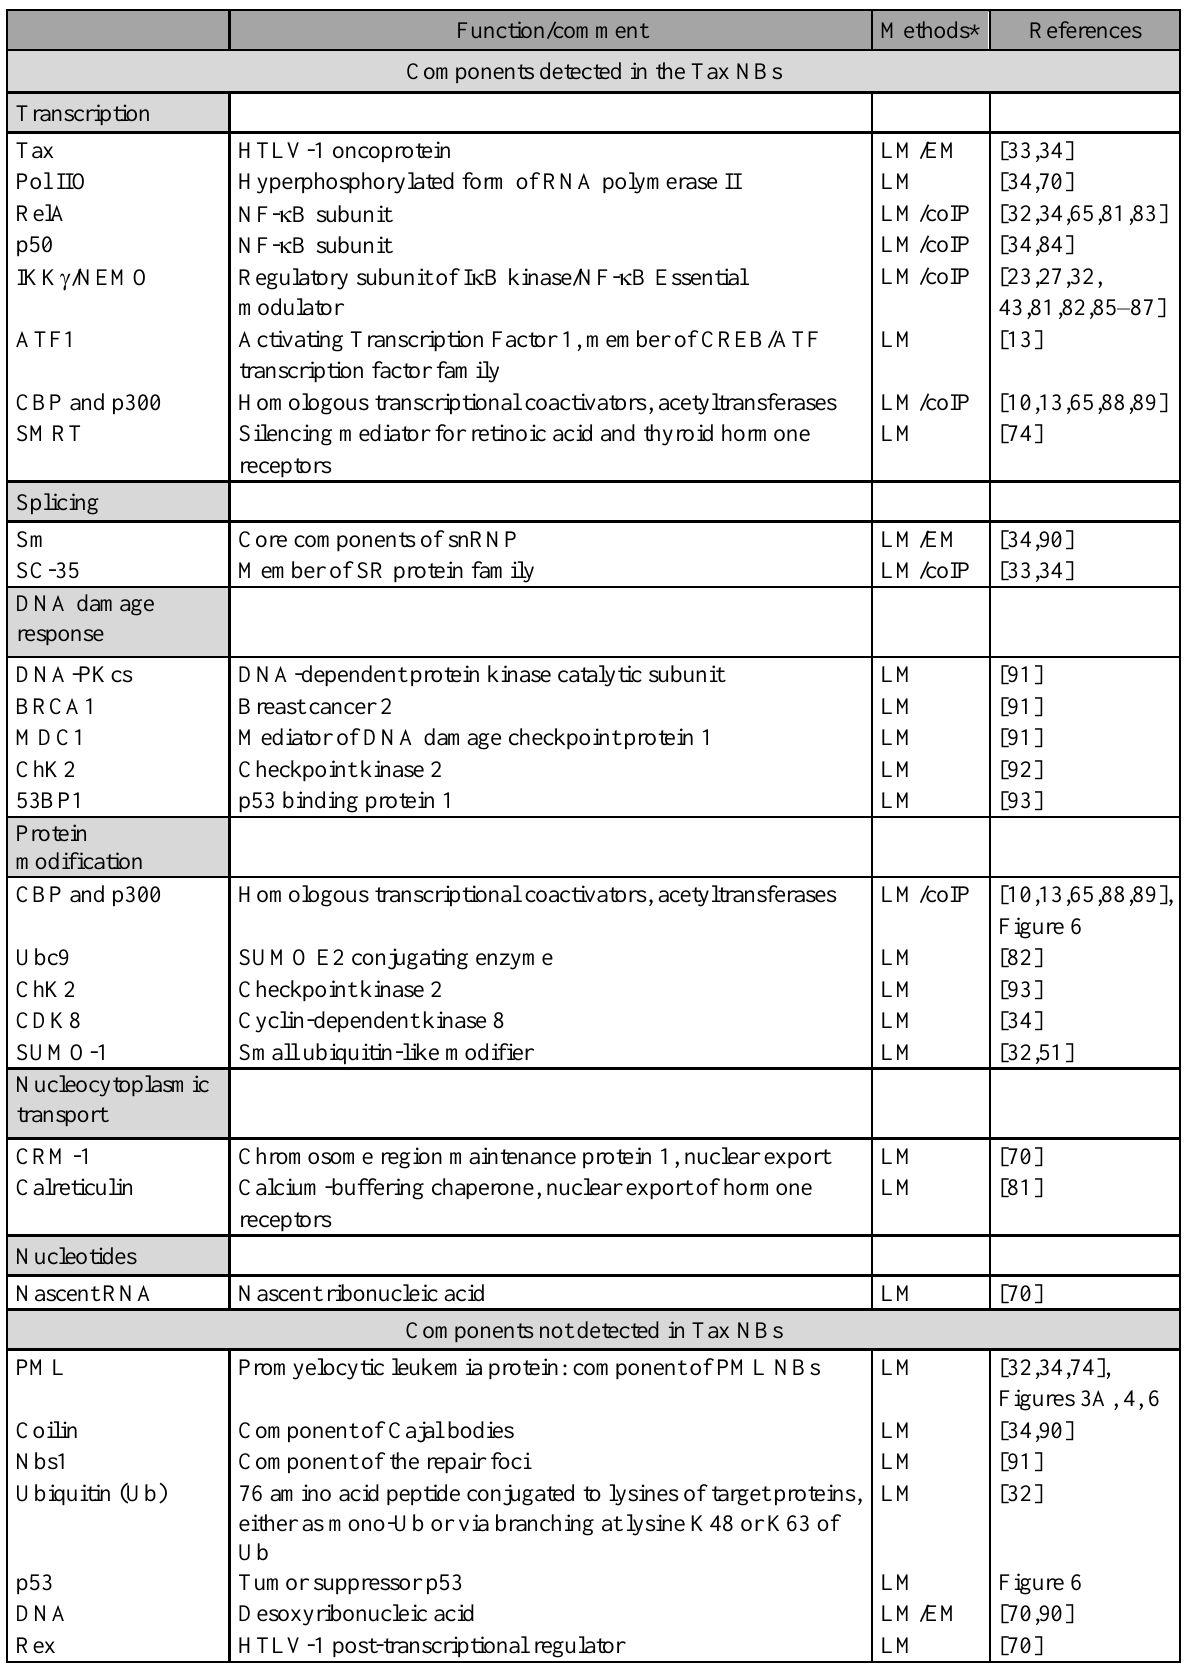
Table 1. Composition of the Tax nuclear